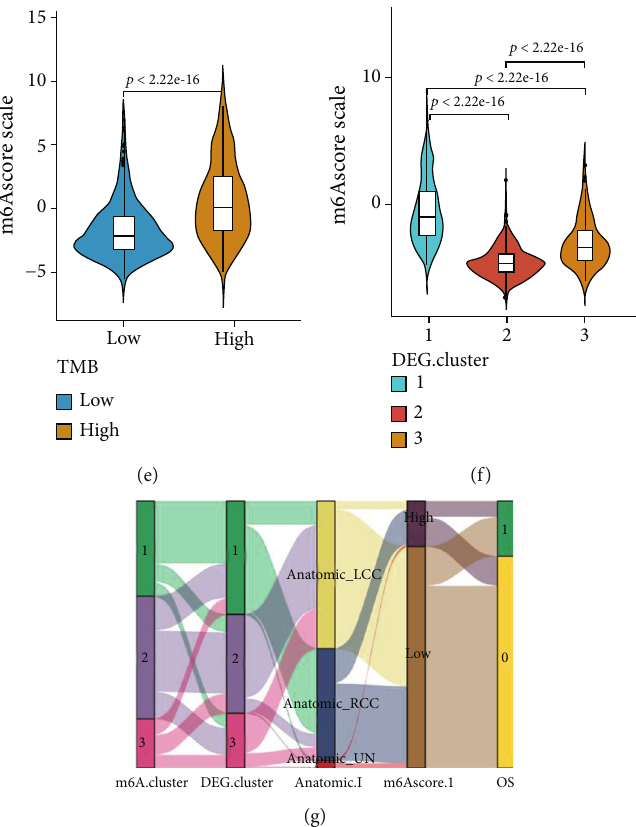
Figure 6: Identi fi cation and characterization of di ff erential expressed gene (DEG) clusters. (a) A heat map of the expression pro fi les of DEGs. (b) Survival curves between DEG clusters. (c) Di ff erential analysis of immunomodulatory molecule expression among DEG clusters. (d) A boxplot for m6Ascores across di ff erent anatomical locations. (e) A boxplot for m6Ascores between high- and low-tumor mutational burden (TMB) subgroups. (f) A boxplot for m6Ascores among DEG clusters. (g) A Sankey diagram illustrating the relationship of m6A cluster, DEG cluster, anatomical location, m6Ascore, and overall survival